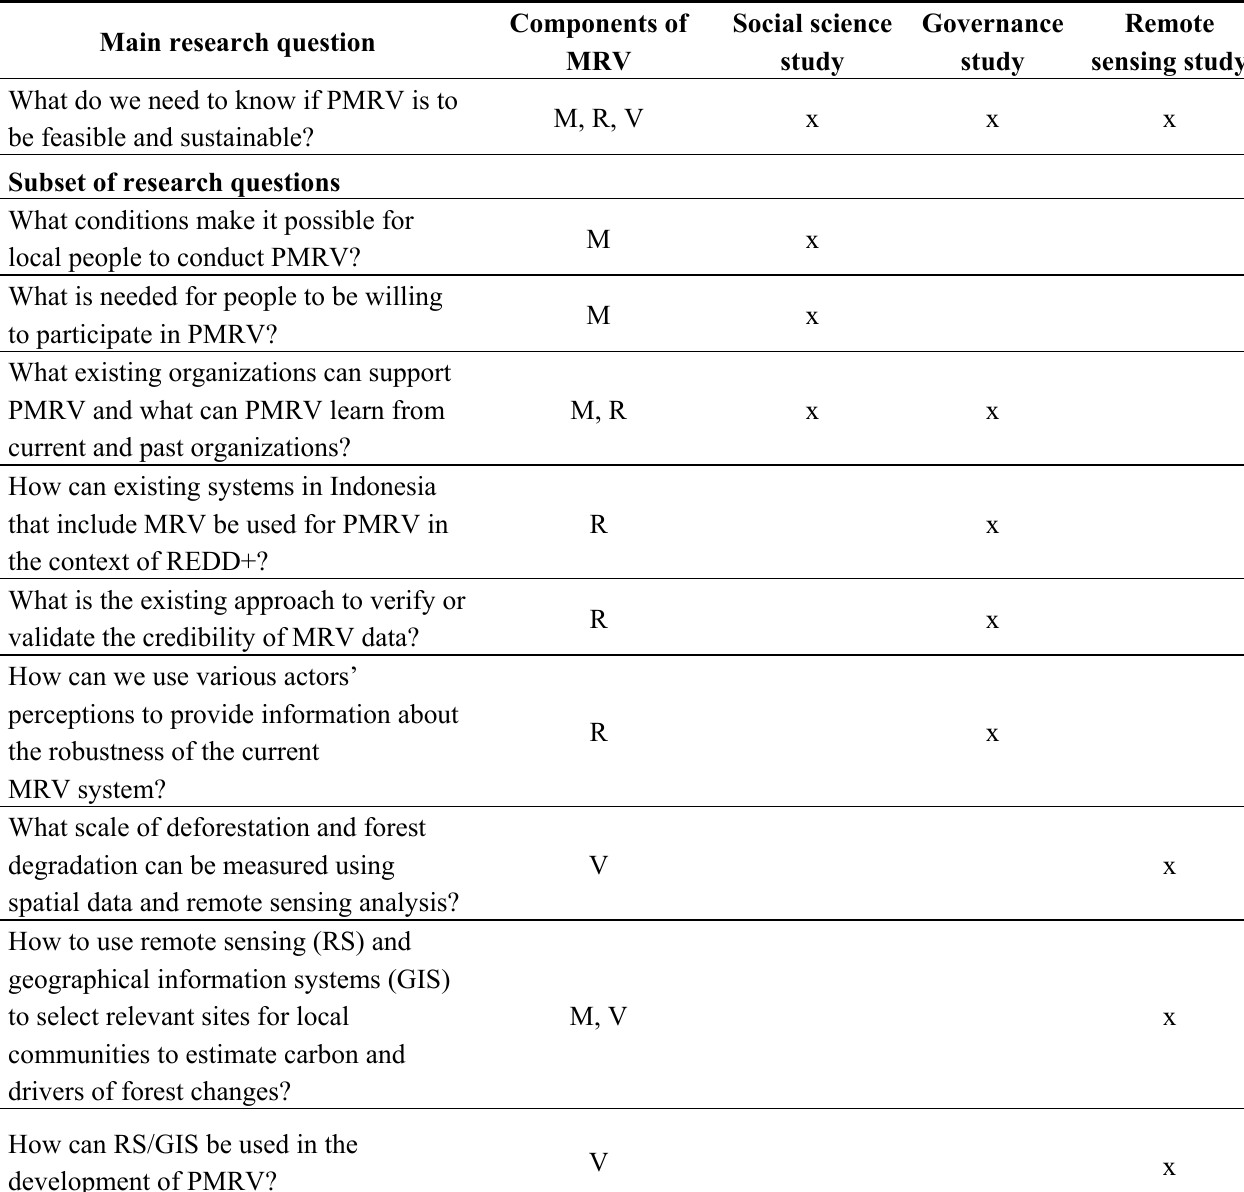
Table 2. Main research question and its subset of research questions by theme and their links to